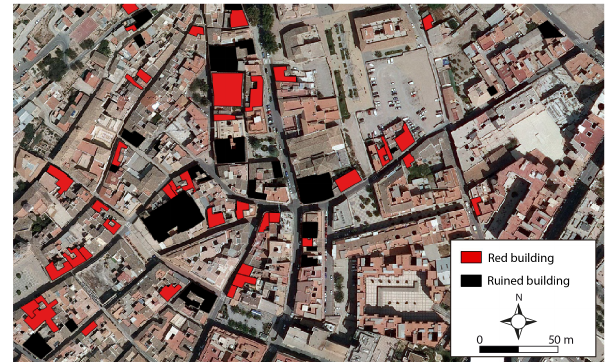
Figure 3. Sample of the selection from the maps of buildings clas- sified red or black (ruined). Map base: PNOA images from the In- stituto Geográfico Nacional. Evaluation of buildings: Servicio de Urbanismo de Planeamiento y Gestion. Production: Marc Bertran Rojo,